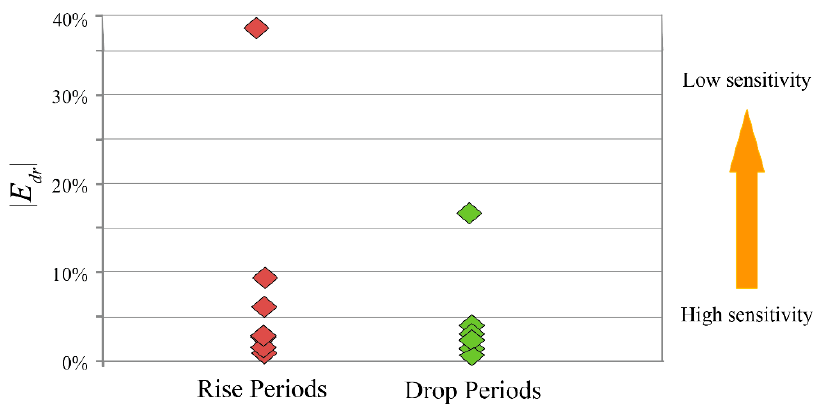
Figure 7. A comparison of the absolute value of the arc elasticity coefficient (| E dr |) between the temperature-rise period and temperature-drop